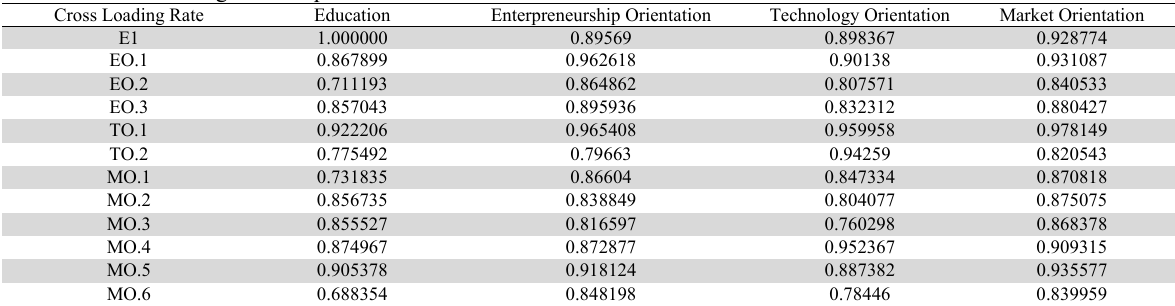
Results of cross loading rate recapitulation Cross Loading Rate